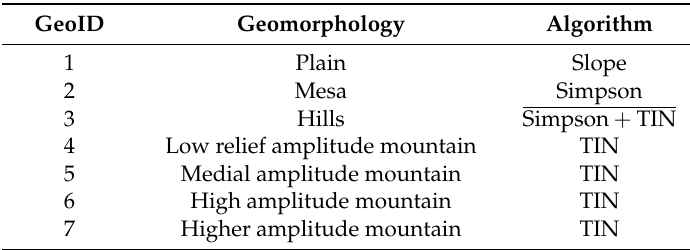
Table 2. Surface area